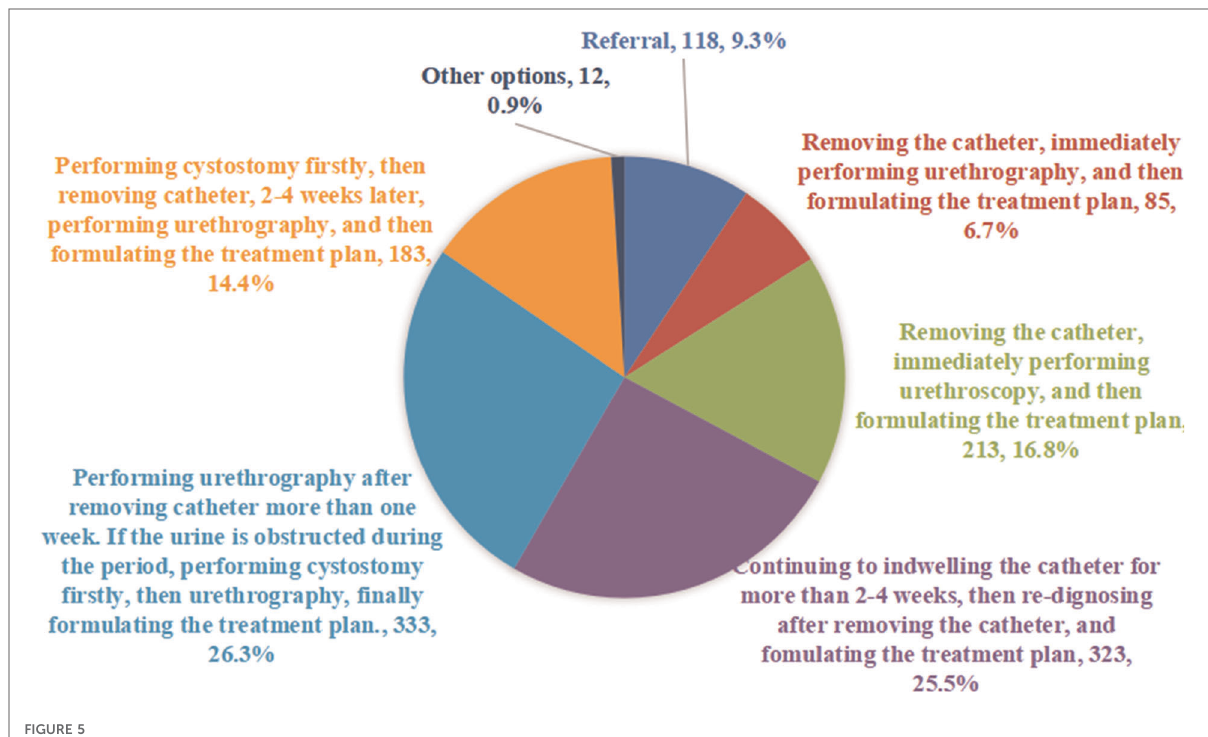
FIGURE 5 Management recommendations of urologists for the Case